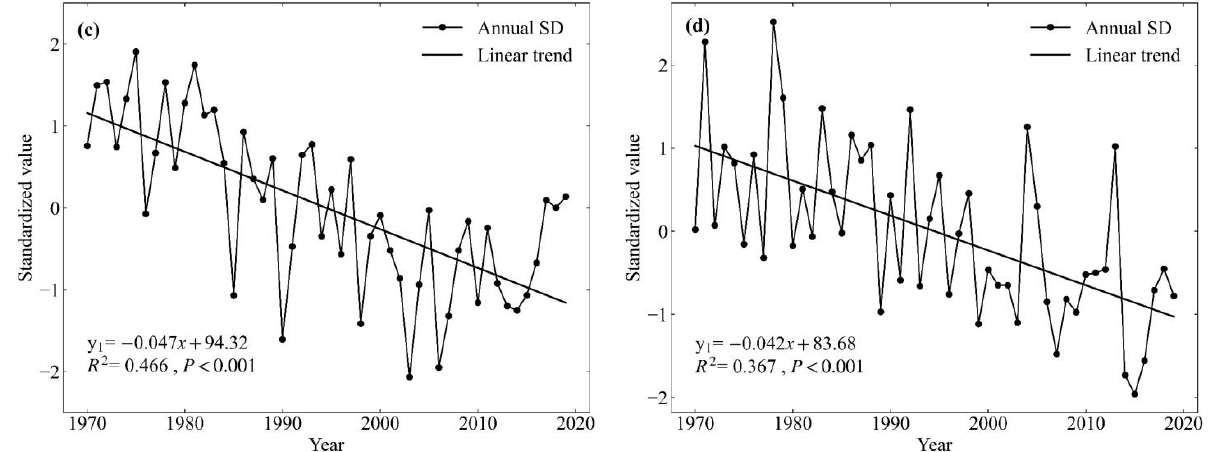
Figure 9. Inter-annual variations of SD in ( a ) Xinjiang, ( b ) Pearl River Delta, ( c ) Beijing-Tianjin- Hebei and ( d ) Yangtze River